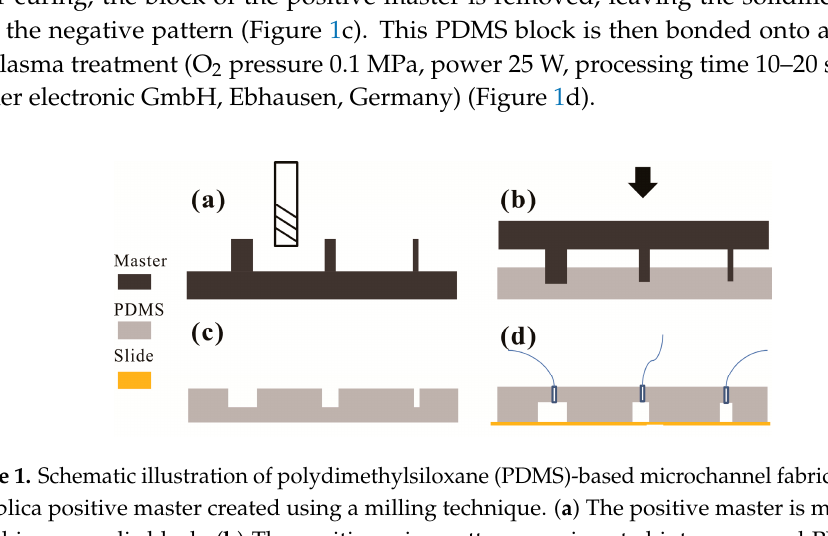
Table 1. Computerized numerical control (CNC) mini-engraving machine specifications.